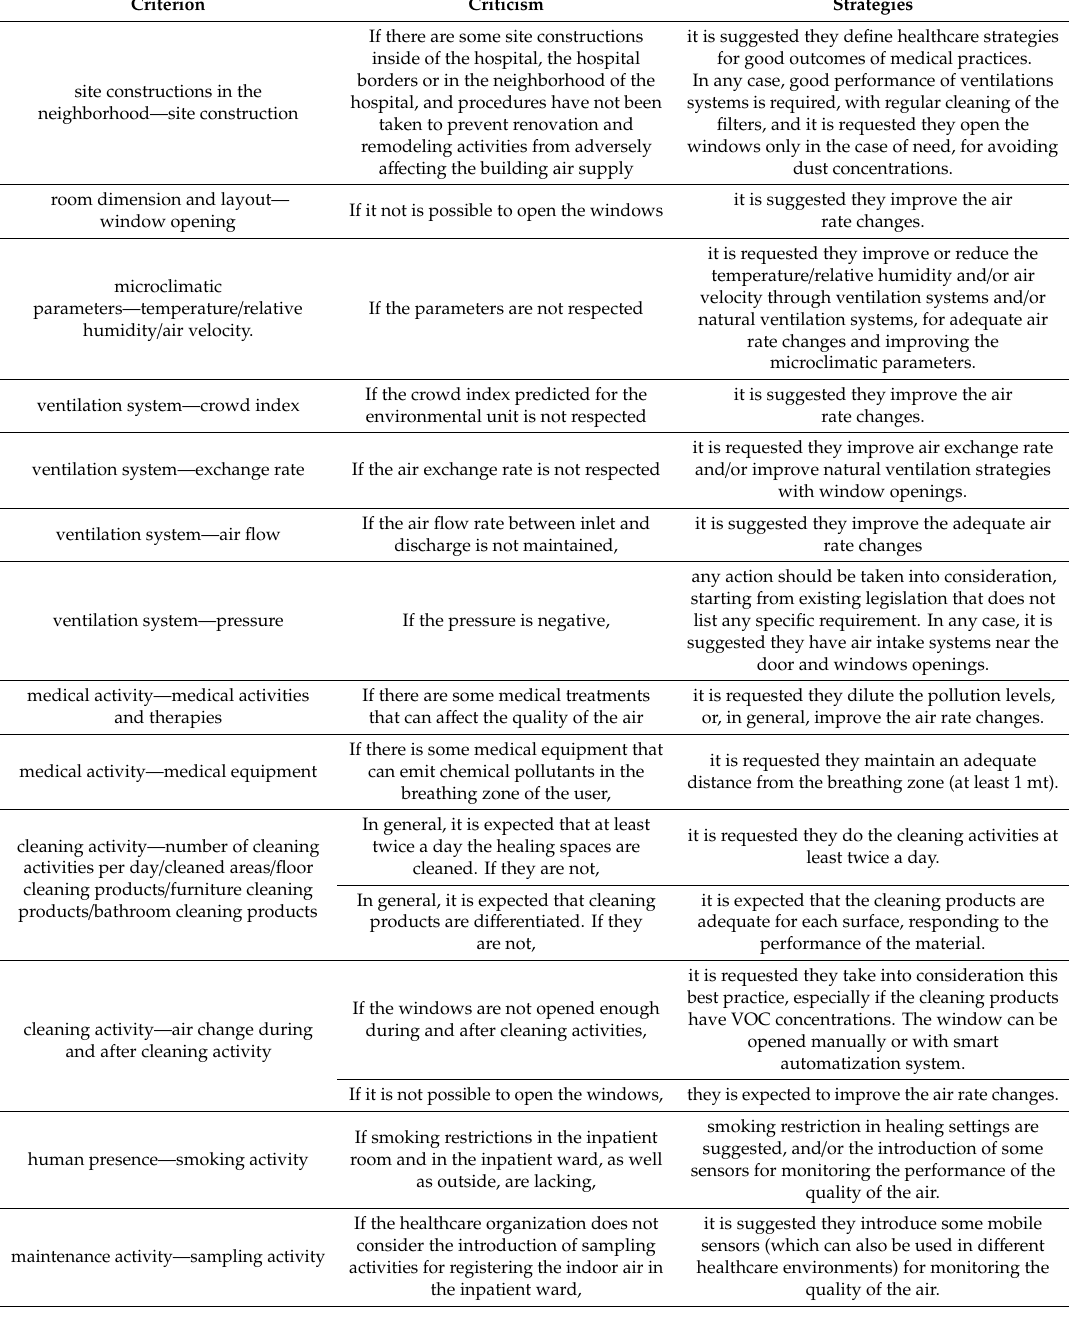
Table 4. Strategies for healthy outcomes in daily